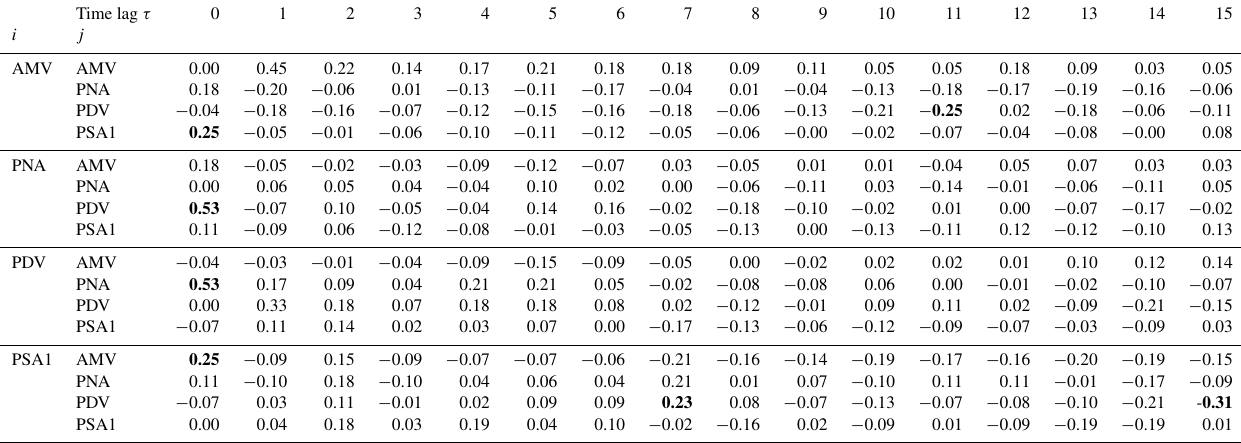
Table A3. Cross-MCI and auto-MCI values calculated by PCMCI + from reanalysis time series data for the complete 1900–2014 period. Values are relative to the complete-period causal graph shown in Fig. 2 (right panel) and in Fig. 5 (upper left panel). The table presents the cross-MCI (cross-correlation) values denoting the sign and strength of the causal link between node i and node j for lags between 0 and τ max . In bold are the highest absolute cross-MCI values for that specific link (detected within the statistical significance threshold, α pc ≤ 0 . 05) and for which links are apparent on the causal graphs. The values are rounded to 2 decimal